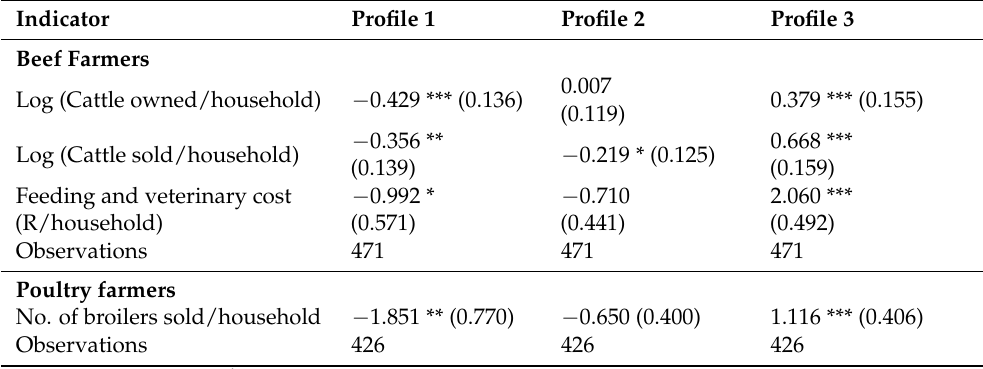
Table 10. Relationship between profile of farmers and performance